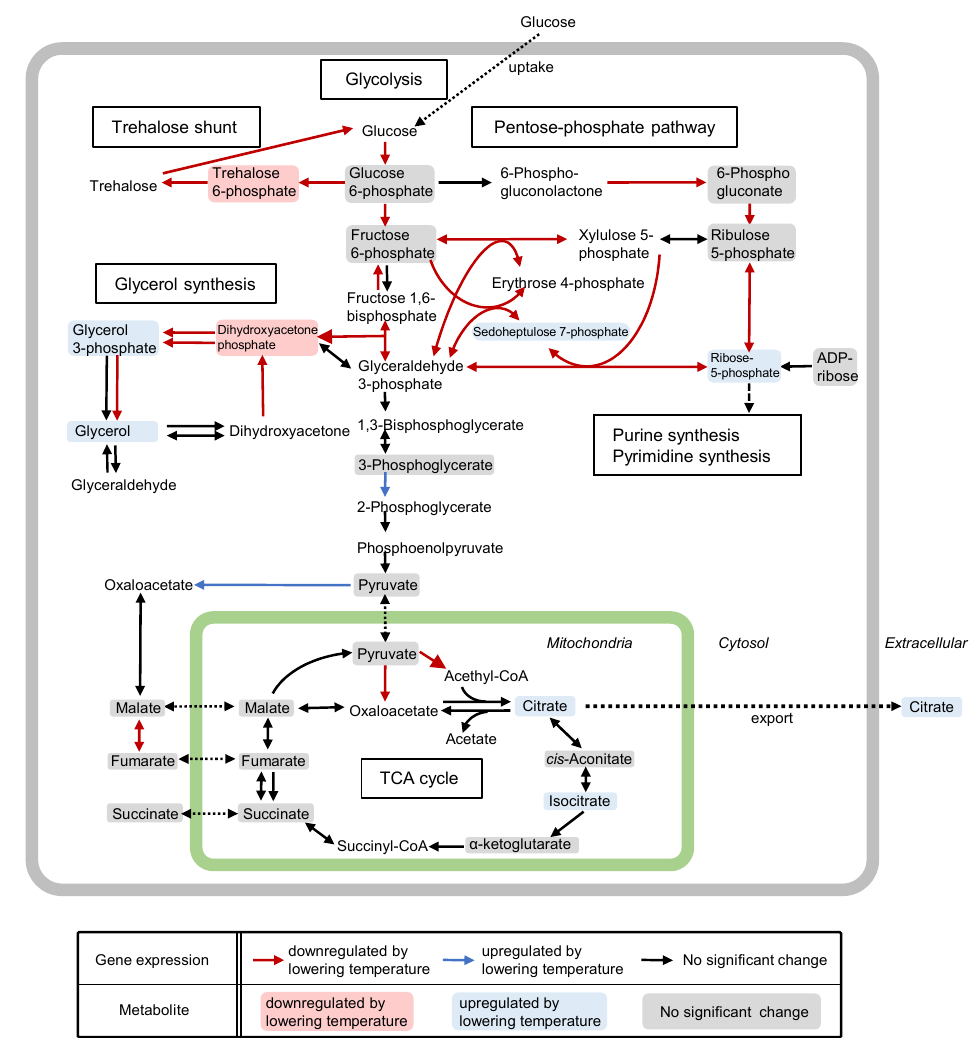
Figure 2. Metabolic map of citric acid synthesis in Aspergillus luchuensis mut. kawachii . Glycolysis, pentose phosphate pathway, trehalose synthesis pathway, glycerol synthesis pathway, and tricarboxylic acid (TCA) cycle are depicted [17]. Different colored arrows and metabolites indicate upregulated, downregulated, or not significantly changed gene expression and metabolite levels as a consequence of lowering the temperature during koji making [17].